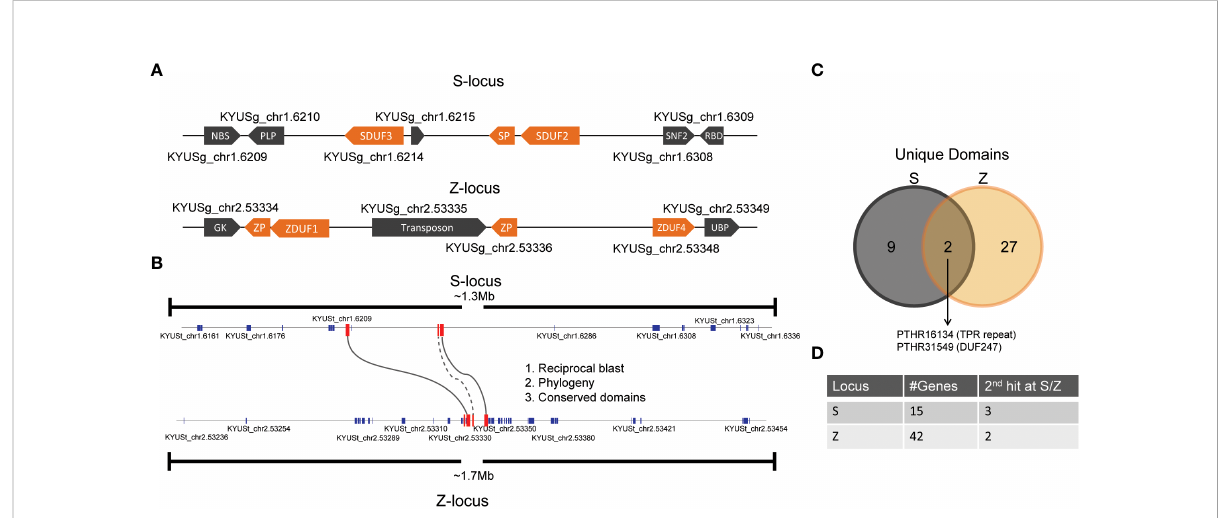
FIGURE 1 Synteny between S- and Z- loci in L. perenne. (A) Structure of the DUF247/SP/ZP at S- and Z-loci in the Kyuss genome (Frei et al., 2021). (B) Annotated genes in a 1.3 and 1.7 Mb region around SDUF247 and ZDUF247 were compared by phylogenetic analysis (see Supplementary Figure 1), BLAST searching and comparing domains in common. Only the DUF247 genes passed all three tests, indicated by solid lines. SP had a second tBLASTn hit at the Z-locus, indicated by a dotted line. (C) Number of unique domains identi fi ed at the S- and Z-loci and the overlap between the two. (D) Number of annotated genes in each region, and the number with secondary tBLASTn hits at the opposing (S/Z)